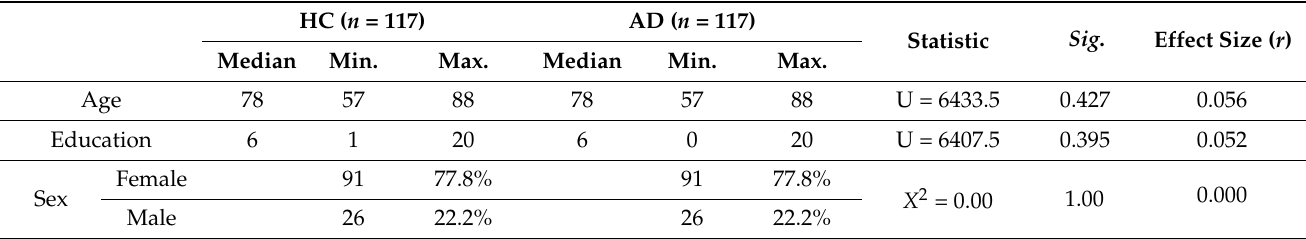
Table 1. Demographic Characteristics of the